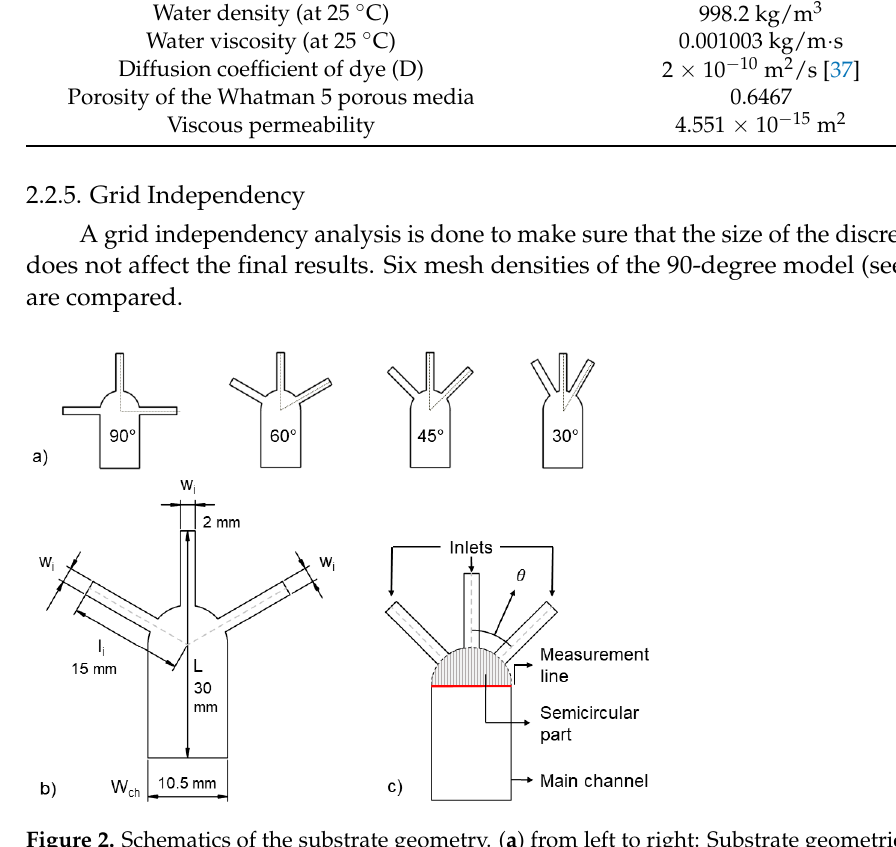
Table 2. Physical properties of fluids and physical characteristics of paper substrate. Property Value